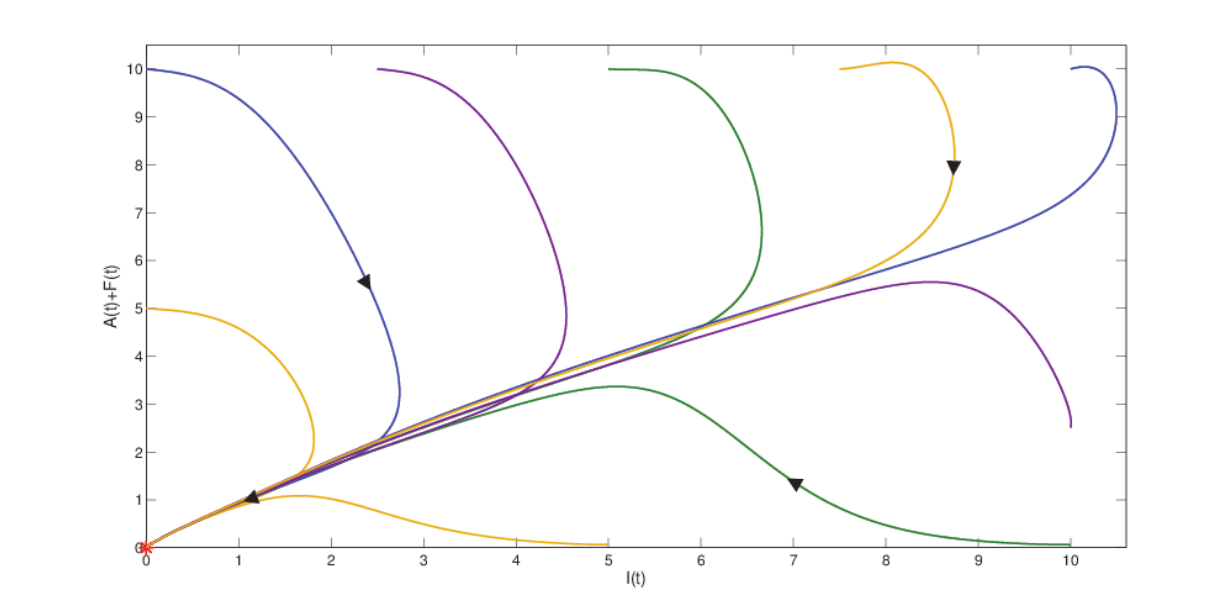
Fig. 5. Illustration that PFE of the host-pathogen model may be globally asymptotically stable when neither of the condition in Theorem 1